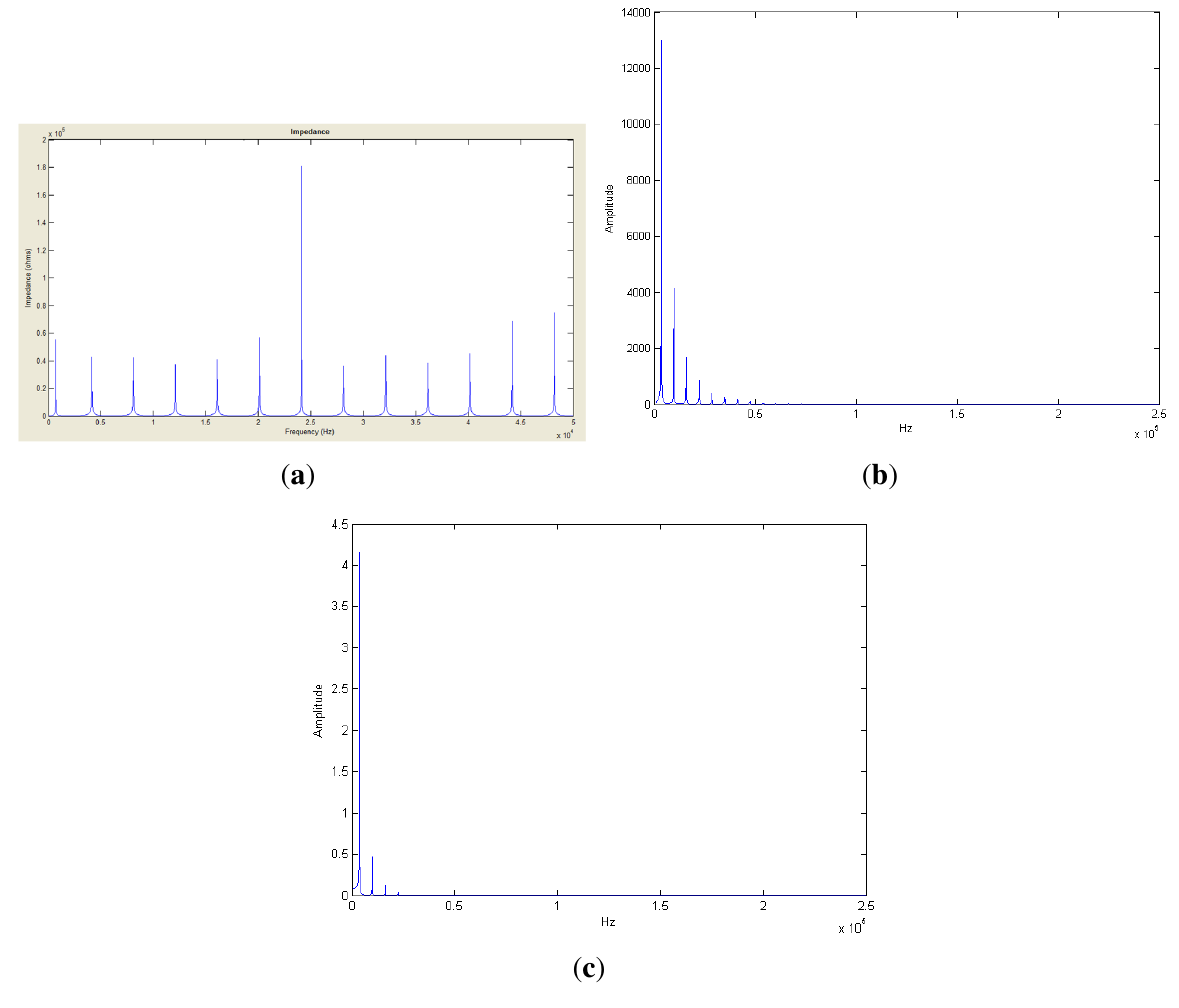
Figure 4. The frequency spectrum of the faulted traction network system. ( a ) the frequency spectrum of Z ; ( b ) the frequency spectrum of the filtered transient voltage signal; and mn ( c ) the frequency spectrum of the filtered transient current